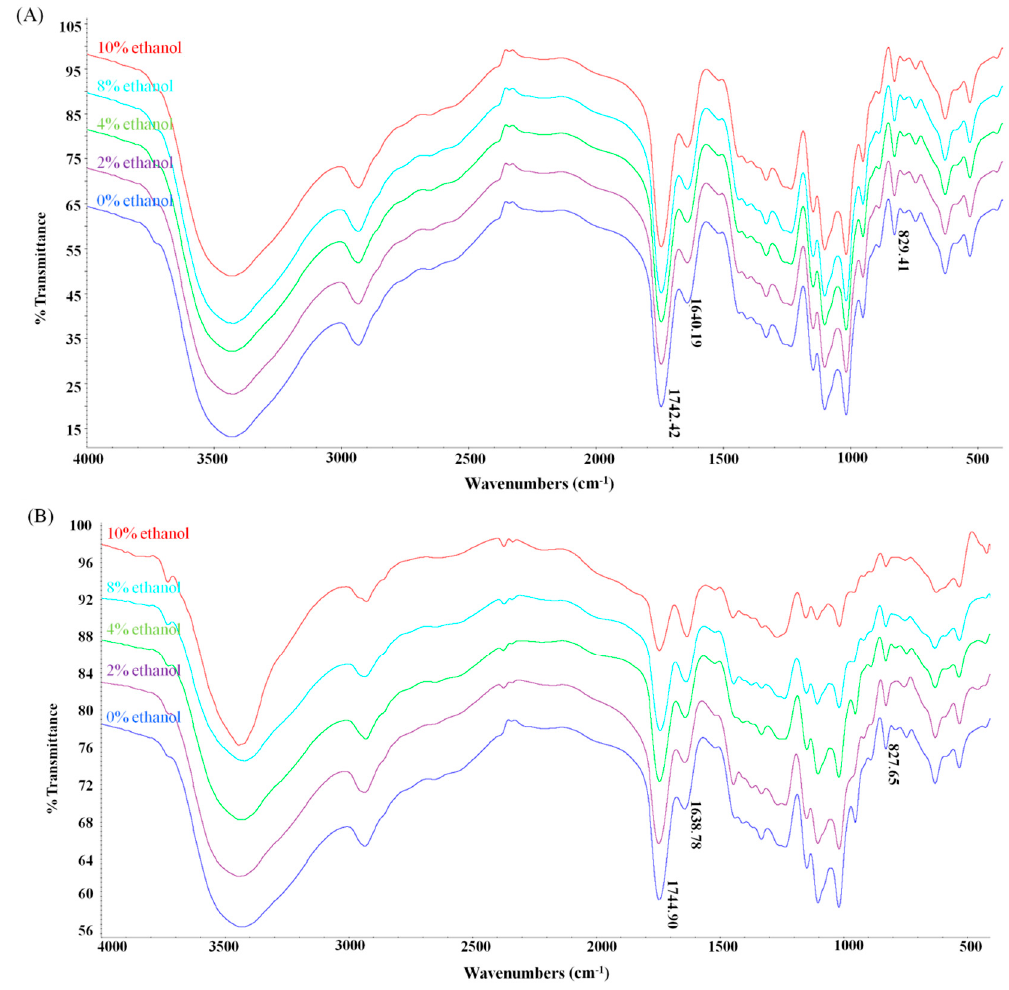
Figure 6. The FT-TR spectra of pectin treated with ( B ) or without ( A ) DHPM under different concentrations.